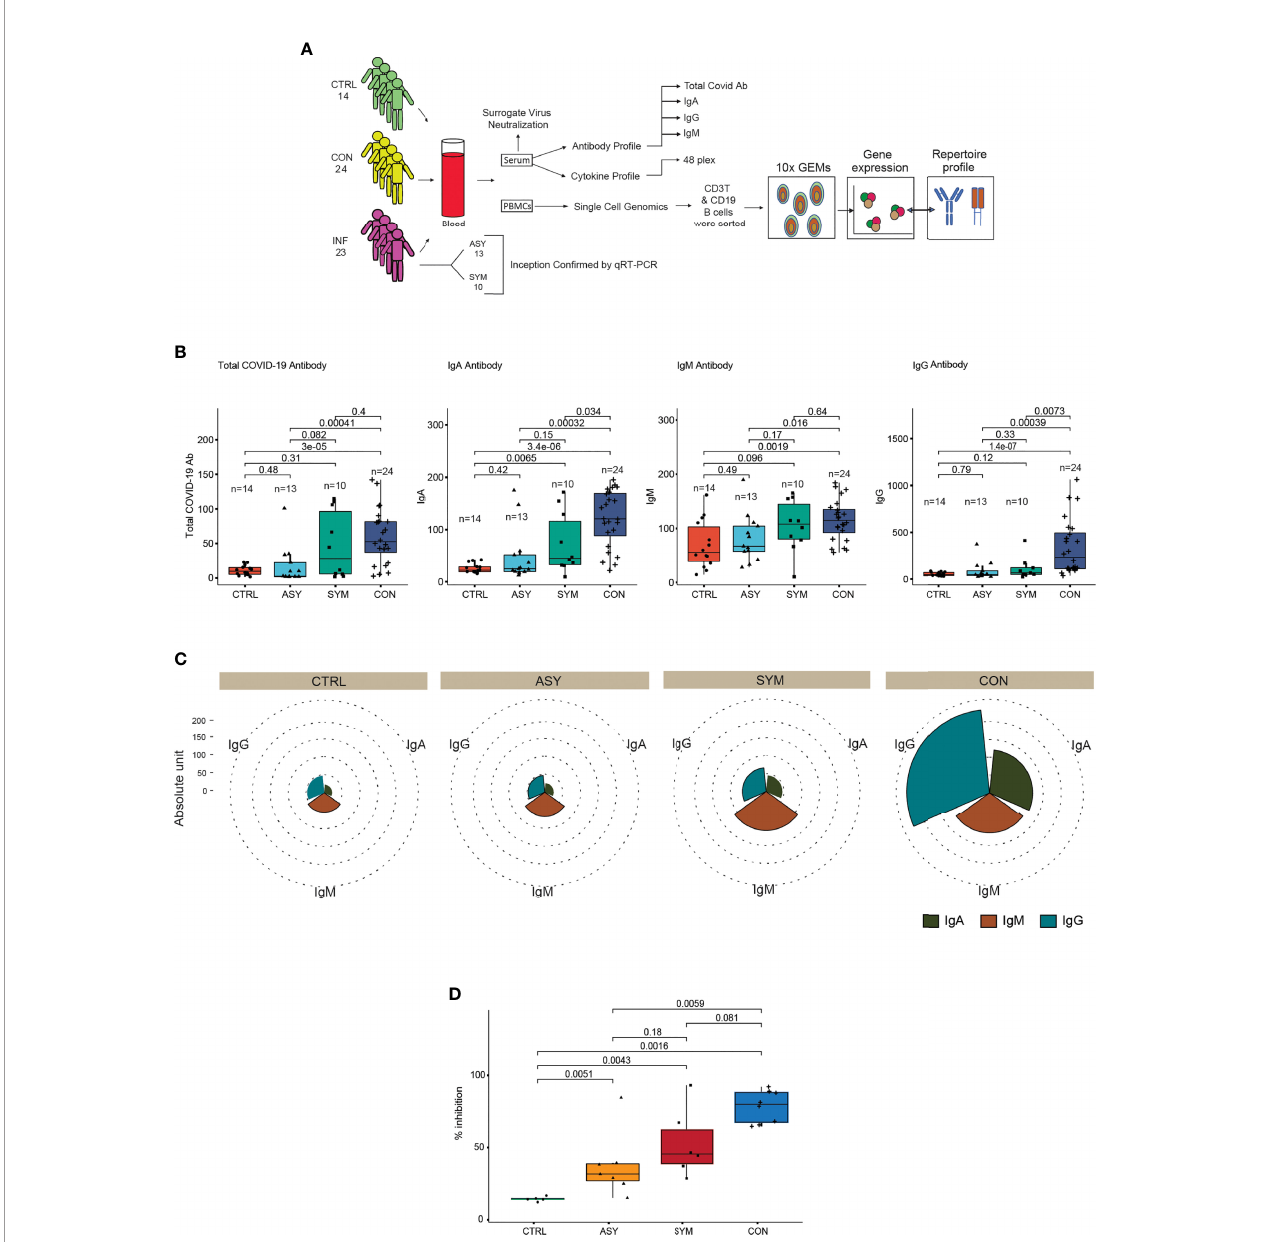
FIGURE 1 | Study approach and distinct antibody responses to SARS-CoV-2 along with neutralization assay. (A) Outline delineating the experimental work fl ow. (B) Box plots showing the anti-SARS-CoV-2 total, IgA, IgM, and IgG antibody proportions in serum samples from controls, symptomatic- and asymptomatic-infected individuals and in contacts (C) . Pie chart showing the overall immunoglobulin response across subject groups. (D) Box plot depicting the percent inhibition of neutralizing antibodies in an in vitro spike RBD-ACE2 interaction-based surrogate virus neutralization assay. Statistical comparisons were performed using unpaired Wilcoxon test. p-values are written against respective comparisons, where n = number of individuals; IgA, immunoglobulin A; IgM, immunoglobulin M; IgG, immunoglobulin G; control (n = 14), infected (n = 23), symptomatic (n = 10), asymptomatic (n = 13), and contact (n =